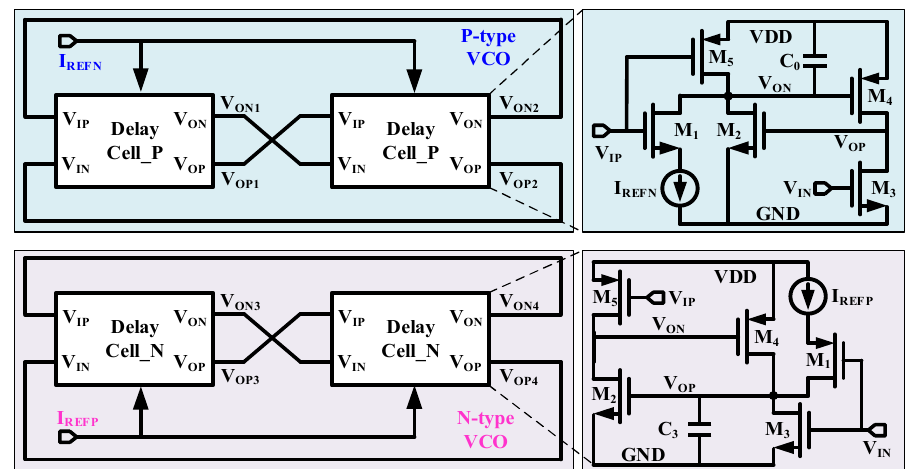
Figure 3. Proposed temperature sensor architecture.